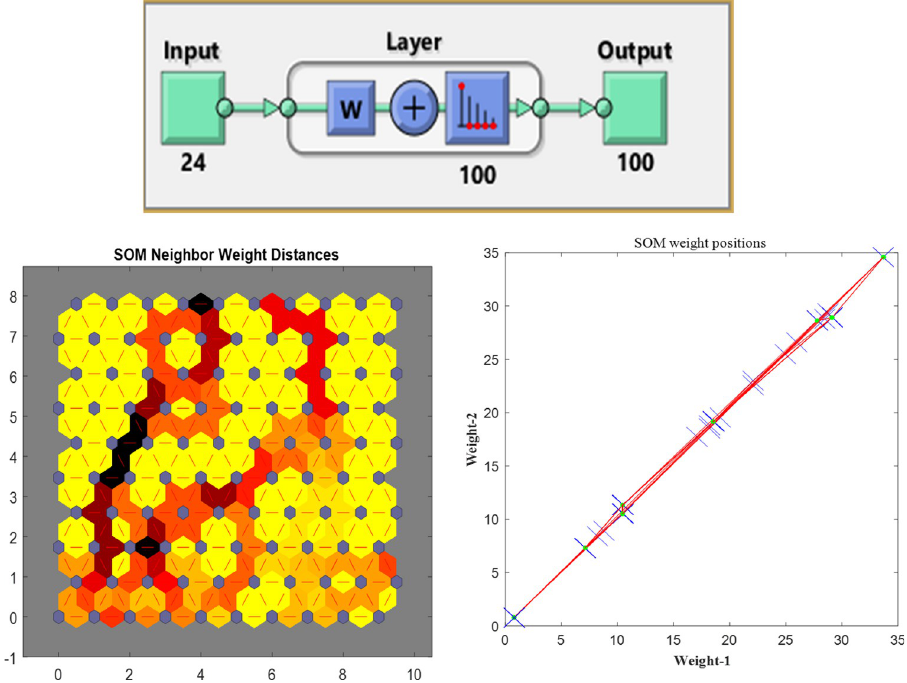
Fig 10. Schematic representation of propagation neural networks technique, self organizing map (SOM) neighbour weight distance and artificial neural networks (ANNs) consisted of several layers of neurons which are inter-connected and then the weights (weight-1 and weight-2) assigned to those